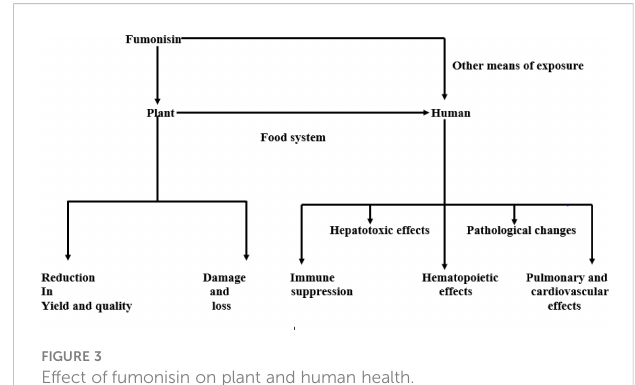
FIGURE 3 Effect of fumonisin on plant and human